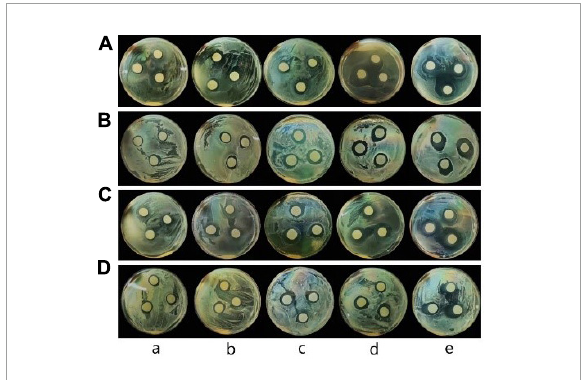
FIGURE5 Photos of the inhibitory zone of CS (a), CS/WPI (b), CS/WPI/TiO 2 (c), CS/WPI/WPEO (d), and CS/WPI/WPEO/TiO 2 (e) films ( A: E. coli ; B: L. monocytogenes ; C: S. aureus ; D: Salmonella